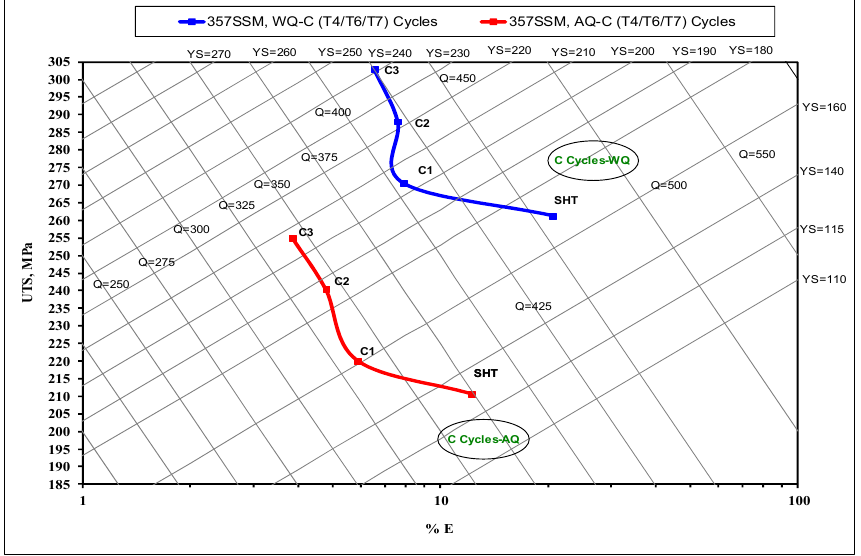
Figure 4. Quality index chart of A357-SSM heat-treated by interrupted aging treatments of T6/T4/T7-C cycle with two quenching media.